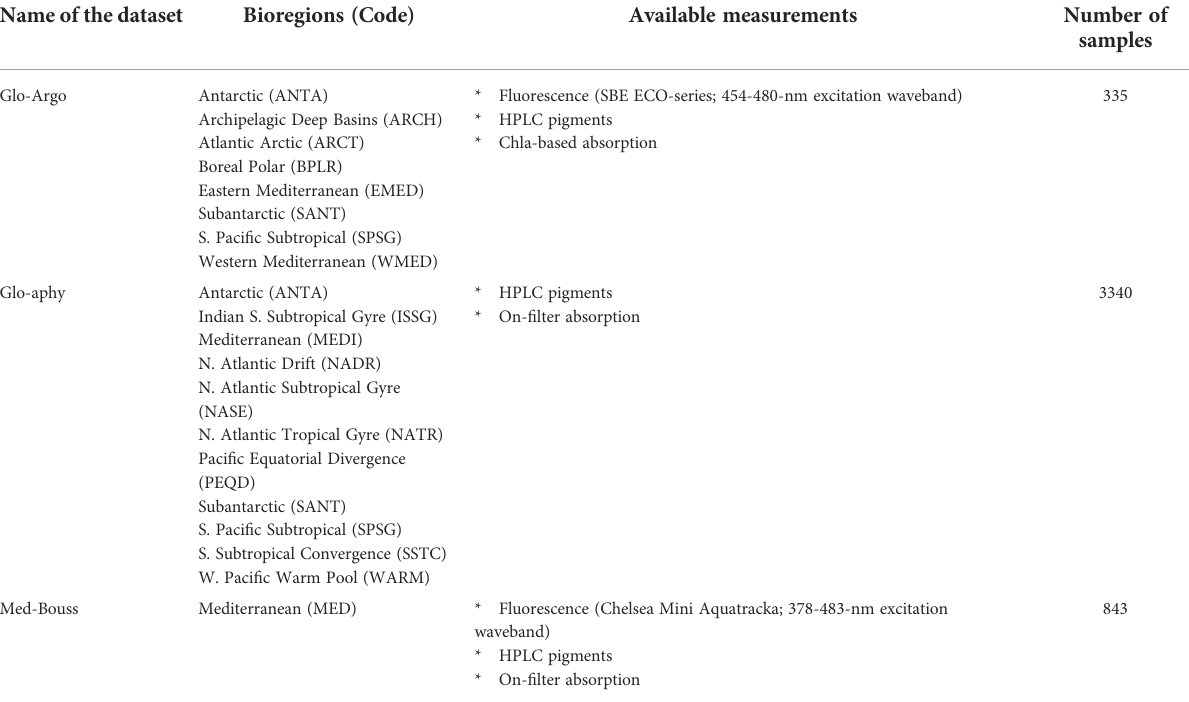
TABLE 1 Summary of the three different datasets used in the present study, the name of the sampled bioregions with the correspond abbreviations, the available measurements and the number of samples in each dataset. Name of the